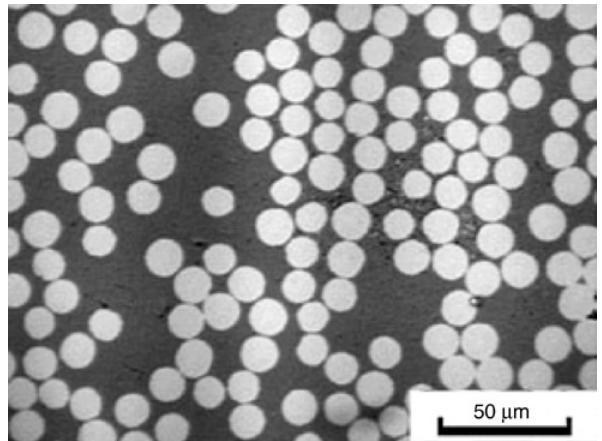
Figure 1: A typical fiber distribution microstructural field